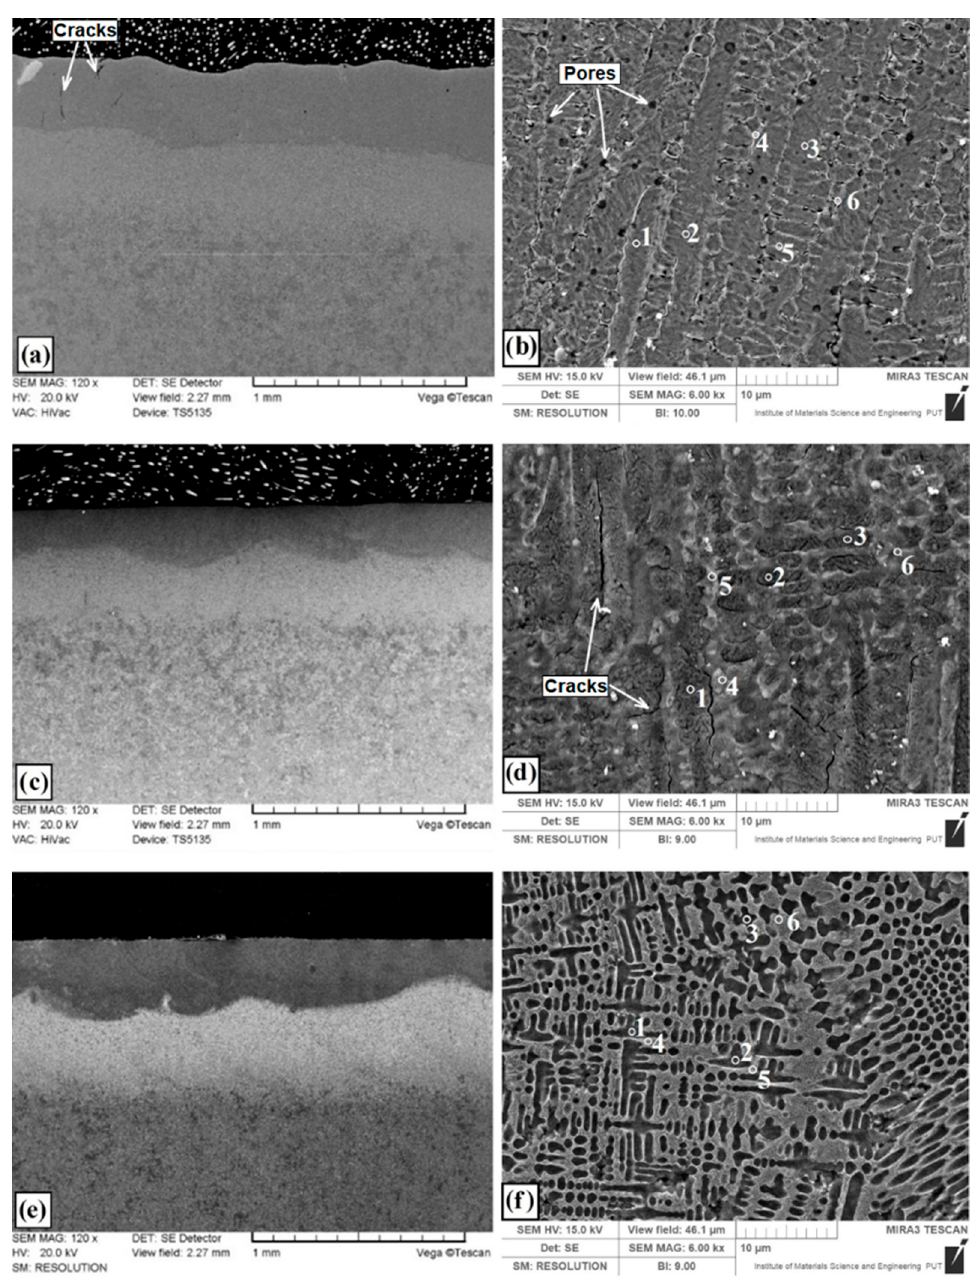
Figure 3. Microstructure of CT90 steel after laser alloying: ( a ) Mo coating; ( b ) Mo coating—magnification remelting zone; ( c ) B coating; ( d ) B coating—magnification remelting zone; ( e ) Mo-B coating; ( f ) Mo-B coating—magnification remelting zone.